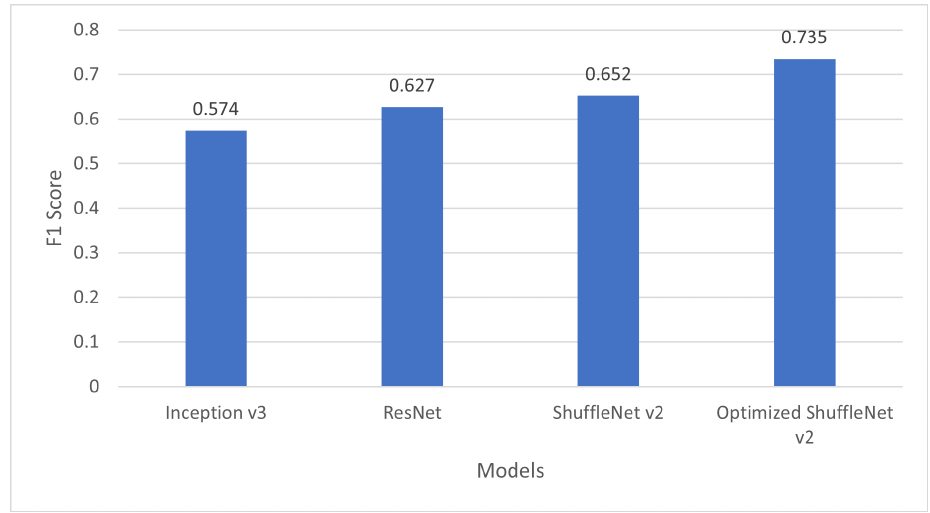
Figure 8. F1-score of different models.